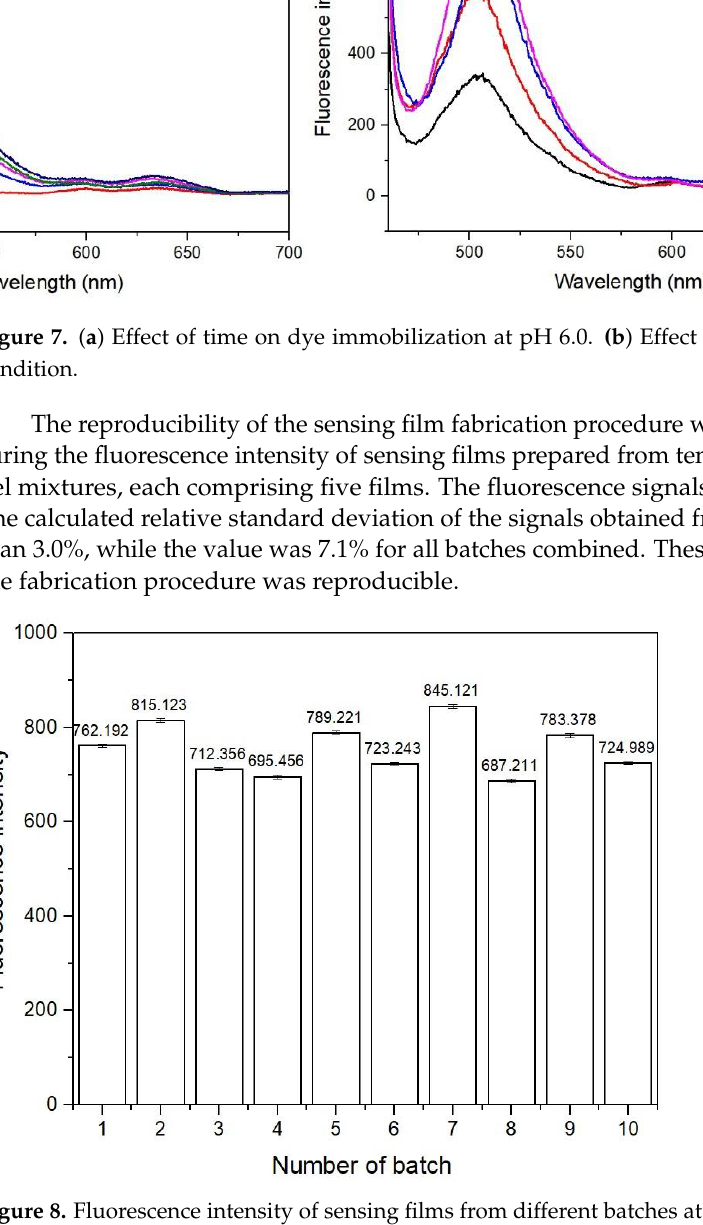
Figure 8. Fluorescence intensity of sensing films from different batches at 506 nm.